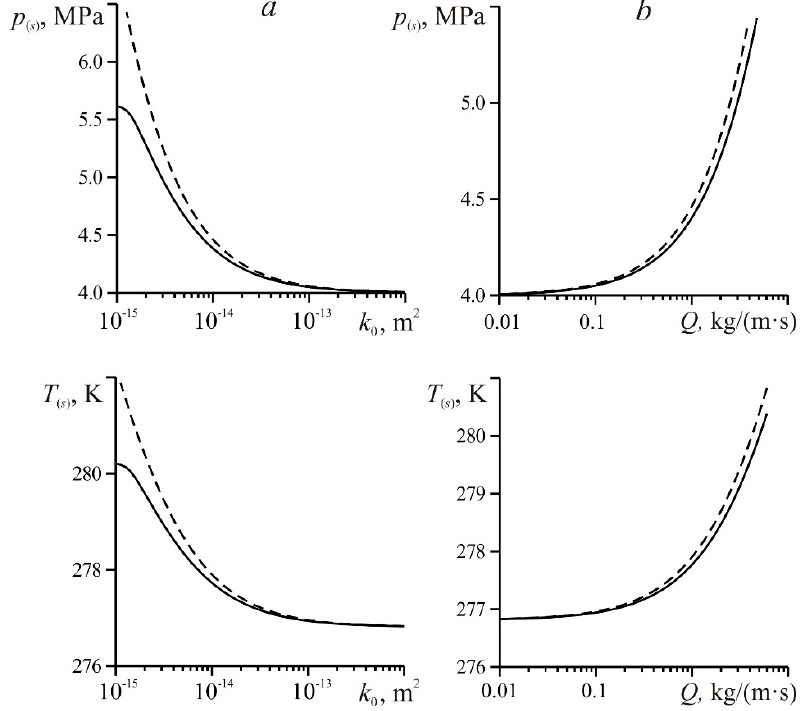
Figure 6. Changes in pressure and temperature at the phase transition boundary depending on the permeability ( a ) and mass flow rate ( b ).